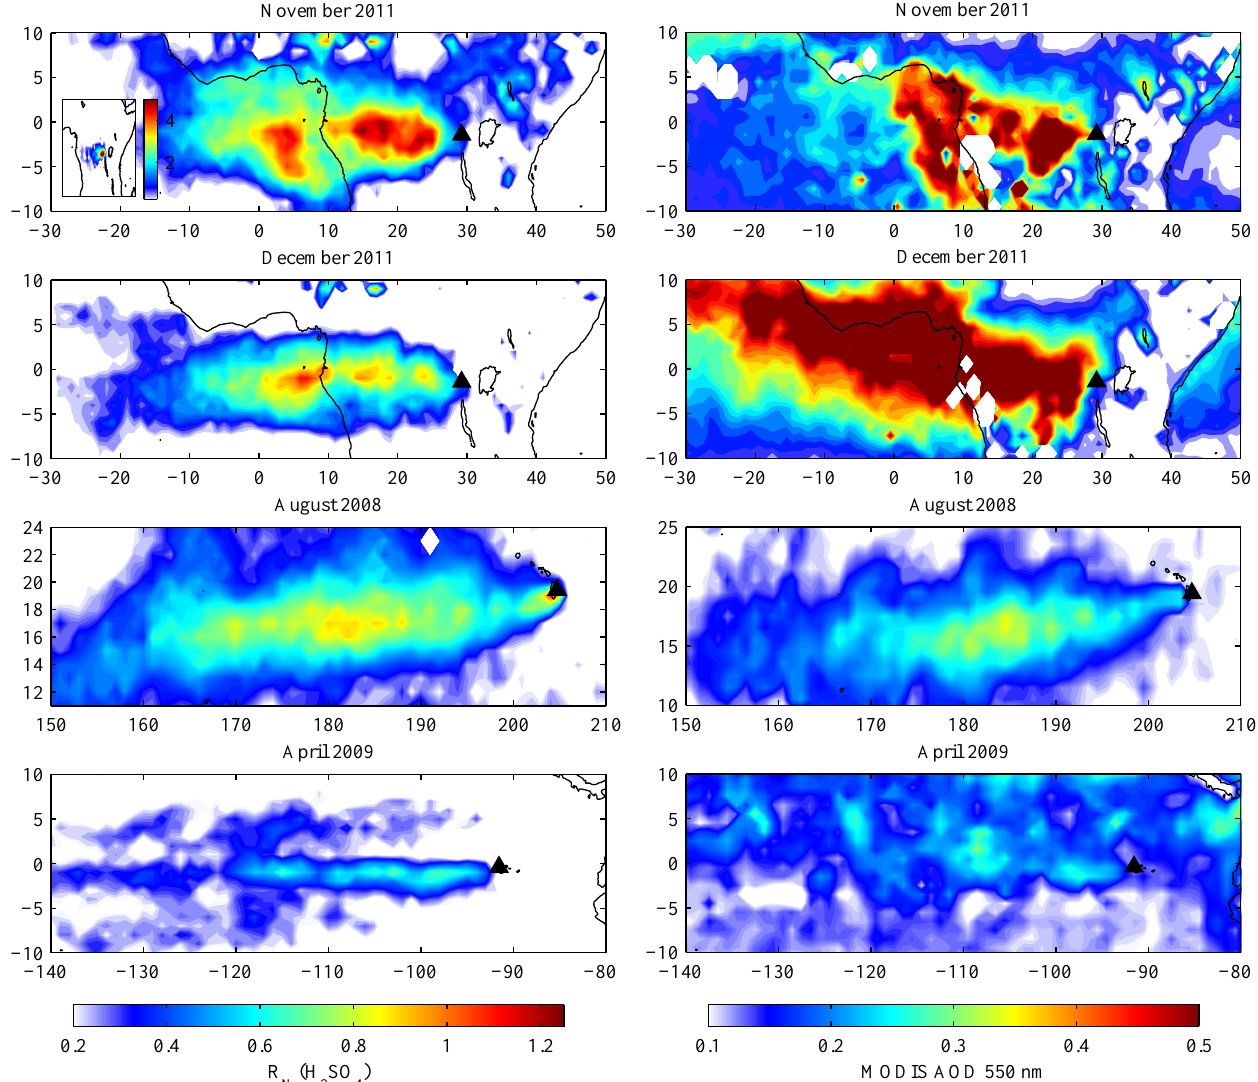
Fig. 3. (left panel) Monthly averaged maps of R N (H 2 SO 4 ) for selected months and locations. The top two plumes are from Nyamuragira (D.R. Congo) in November and December 2011. The inset in the top left panel shows the corresponding OMI SO 2 average in DU (figure courtesy N. Theys, see Theys et al., 2012). The bottom two plumes are from Kilauea (Hawaii) for August 2008 and Fernandina (Gal´apagos Islands) for April 2009. (right panel) MODIS aerosol optical depth (550nm) for the same events and time periods. MODIS data downloaded from the Giovanni online data system (http://disc.sci.gsfc.nasa.gov/giovanni/overview).